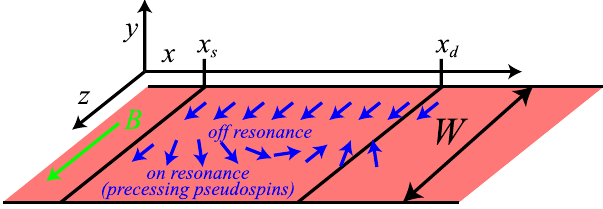
FIG. 1. Schematic representation of the experimental setup of Ref. [26]. A quasi-one-dimensional channel of width W is defined by confinement of a two-dimensional electron gas in the xz plane. The in-plane magnetic field is applied in the ˆ z direction. x and x denote the location of the source and drain of spin s d polarization along the channel.